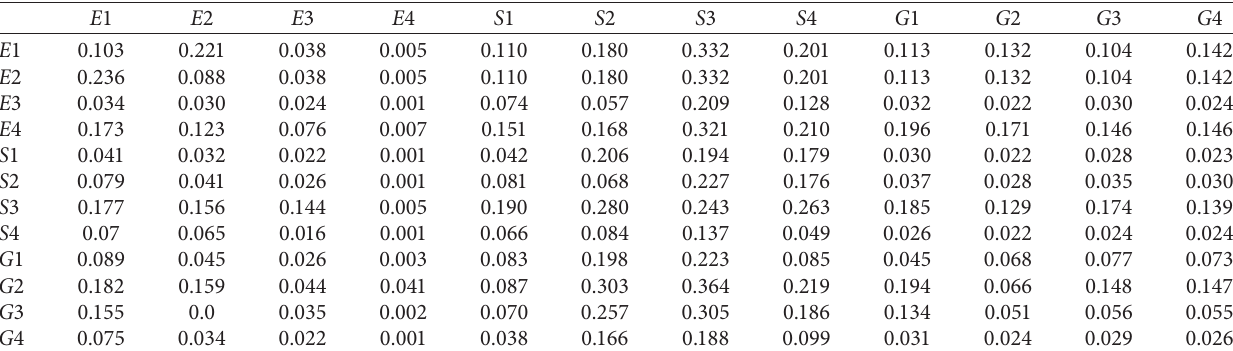
Table 29: Total relationship matrix of sustainability criteria in deterministic condition.